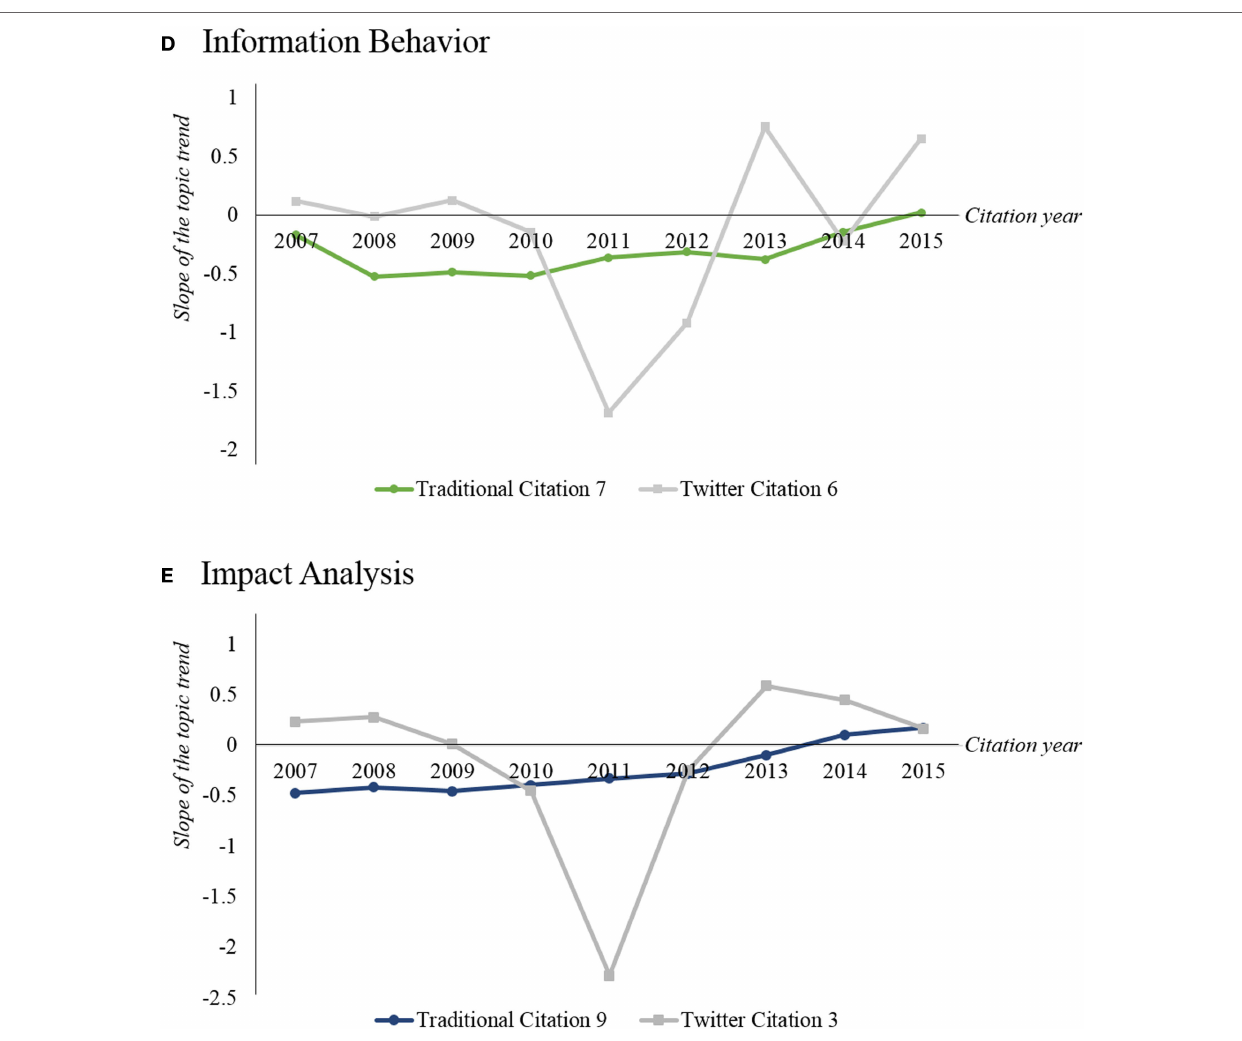
FigUre 5 | Topical trends of (a) traditional and (B) Twitter citations; comparison between traditional and Twitter citation trends for (c) topic 0 (traditional) and topic 9 (Twitter), (D) topic 7 (traditional) and topic 6 (Twitter), and (e) topic 9 (traditional) and topic 3 (Twitter); The y -axis is the slope of the topic trend and the x -axis is the citation year